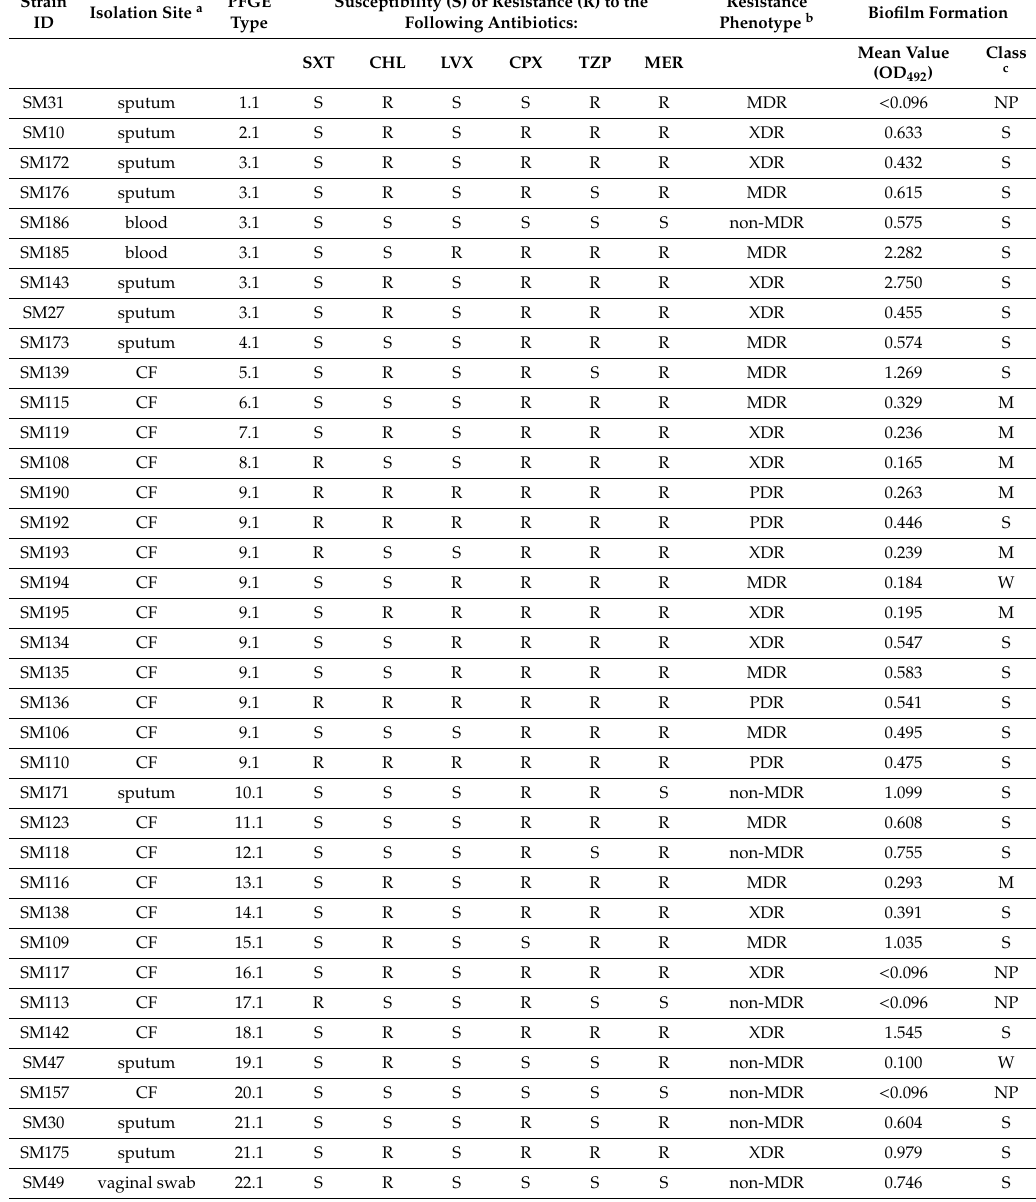
Table 1. Clonal relatedness, antibiotic-resistance, and biofilm formation of 85 S. maltophilia strains tested in the present study. Strains were genotyped by PFGE analysis. Susceptibility tests were performed using Kirby–Bauer disk di ff usion agar (SXT, cotrimoxazole; LVX, levofloxacin; CPX, ciprofloxacin; TZP: Piperacillin / tazobactam; MER, meropenem) or broth microdilution technique (CHL, chloramphenicol) and interpreted according to CLSI guidelines [22]. Biofilm formation was assessed by spectrophotometric assay after crystal violet assay and the results were categorized according to Stepanovic et al.